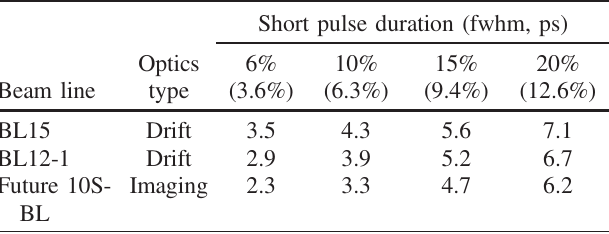
TABLE II. Short pulse duration (fwhm) for the SPEAR3 2FCC scheme for various flux percentages. Percentages in parentheses include bunch lengthening for a 20 mA bunch charge. Crab cavities are located in 1S, with V 1 ¼ 1 MV. Pulse duration degradation for the 10S-BL (w/imaging) is about ∼ 30% (not